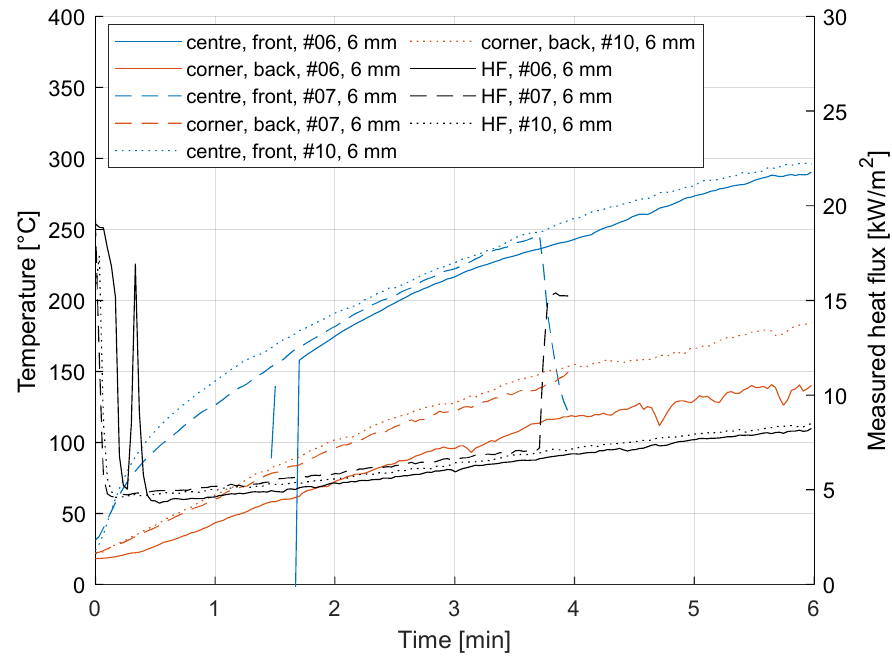
Figure 7. Temperature development and measured heat flux for 6 mm thick specimens (Test #6, #7 and #10).